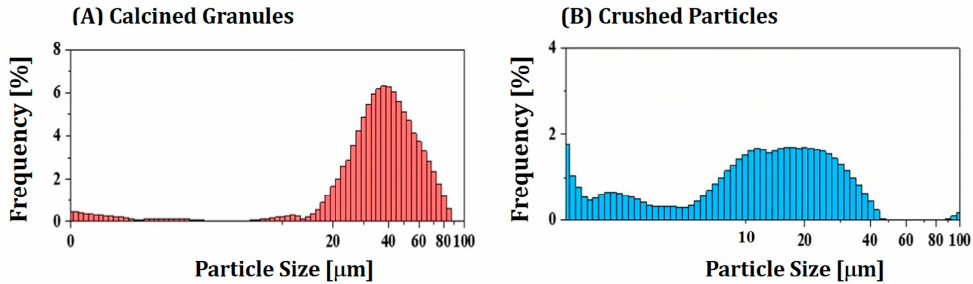
Figure 3. Particle size distributions of ( A ) calcined 4Y-PSZ granules and ( B ) ball-milled 4Y-PSZ powders.